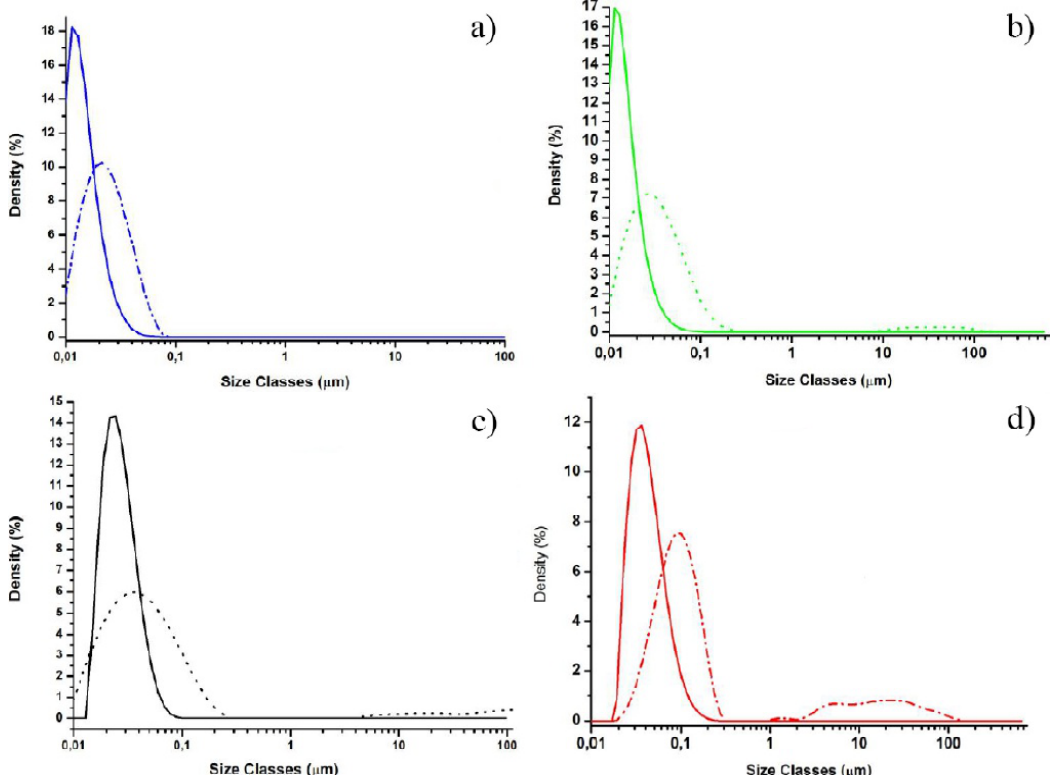
Fig. 4. The volume (dashed line) and numerical (solid line) distributions of particles of iron- a), cobalt - b), nickel - c) and copper - d)